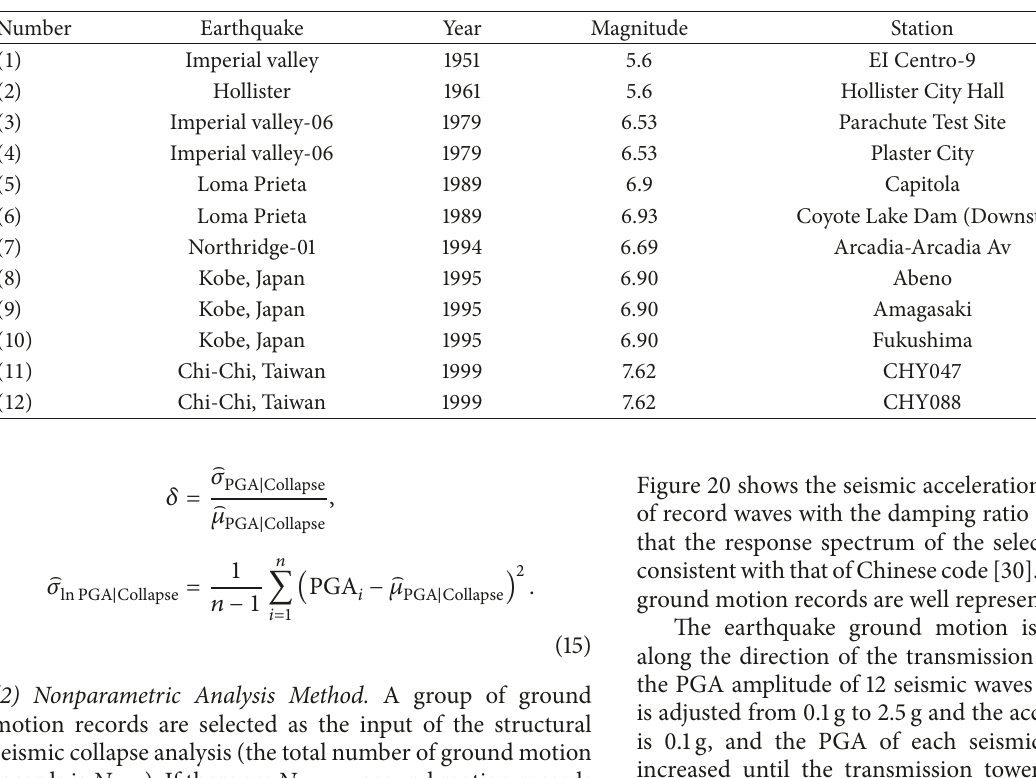
Table 7: Characteristics of the earthquake ground motion